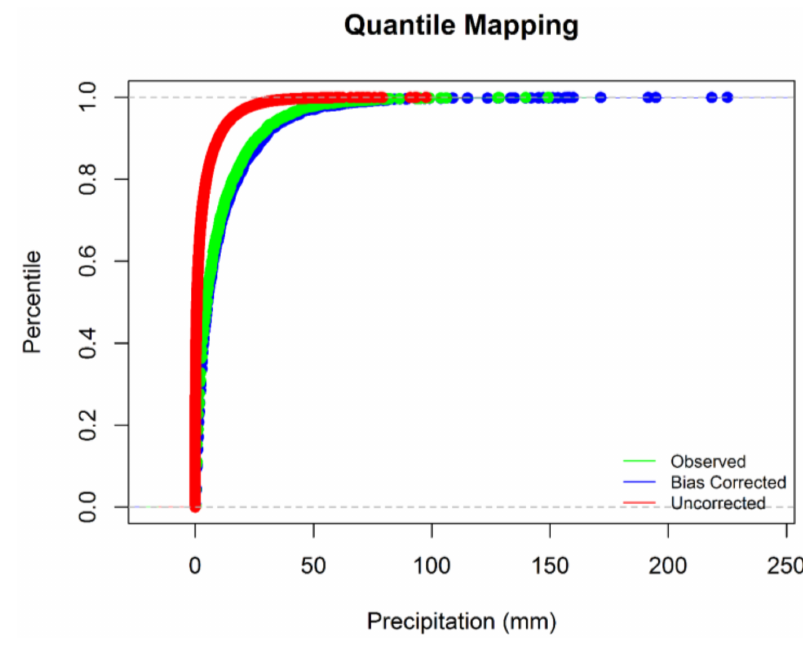
Figure 6. Quantile mapping approach for the correction of dry bias and representation of future extreme events (Plotted data: RCP 8.5